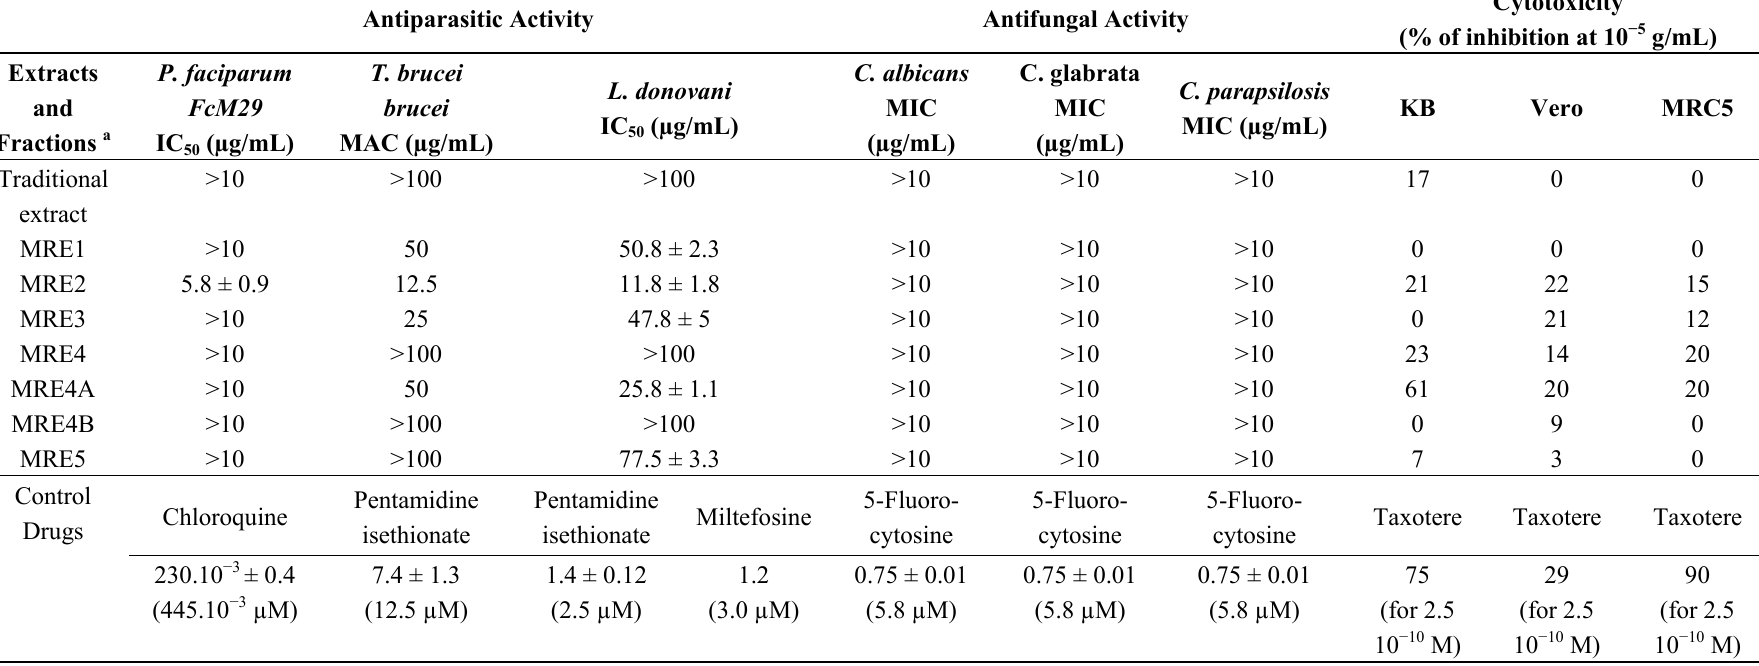
Table 2. Biological activities of extracts and fractions of M.